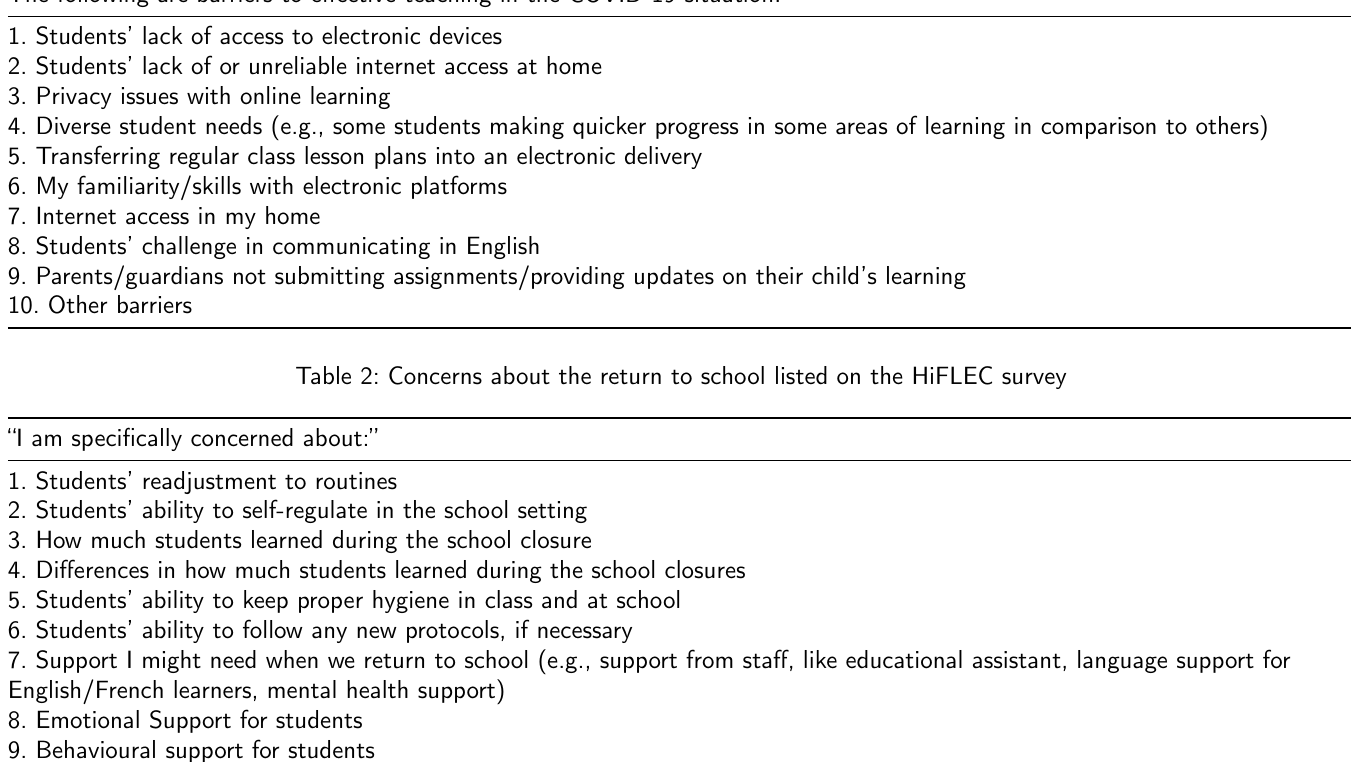
Table 1: Barriers to online learning listed on the HiFLEC survey